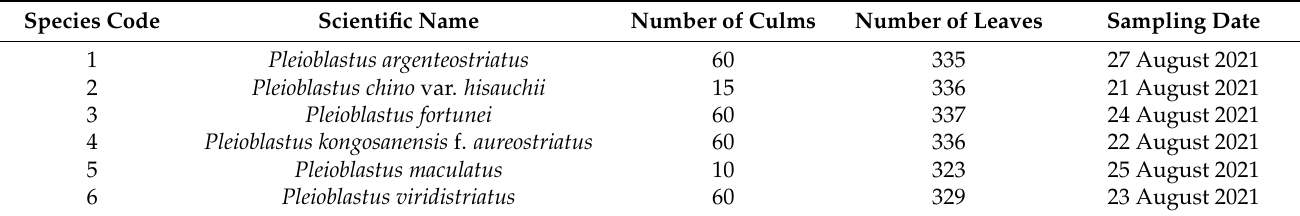
Table 1. Sampling information of the six bamboo